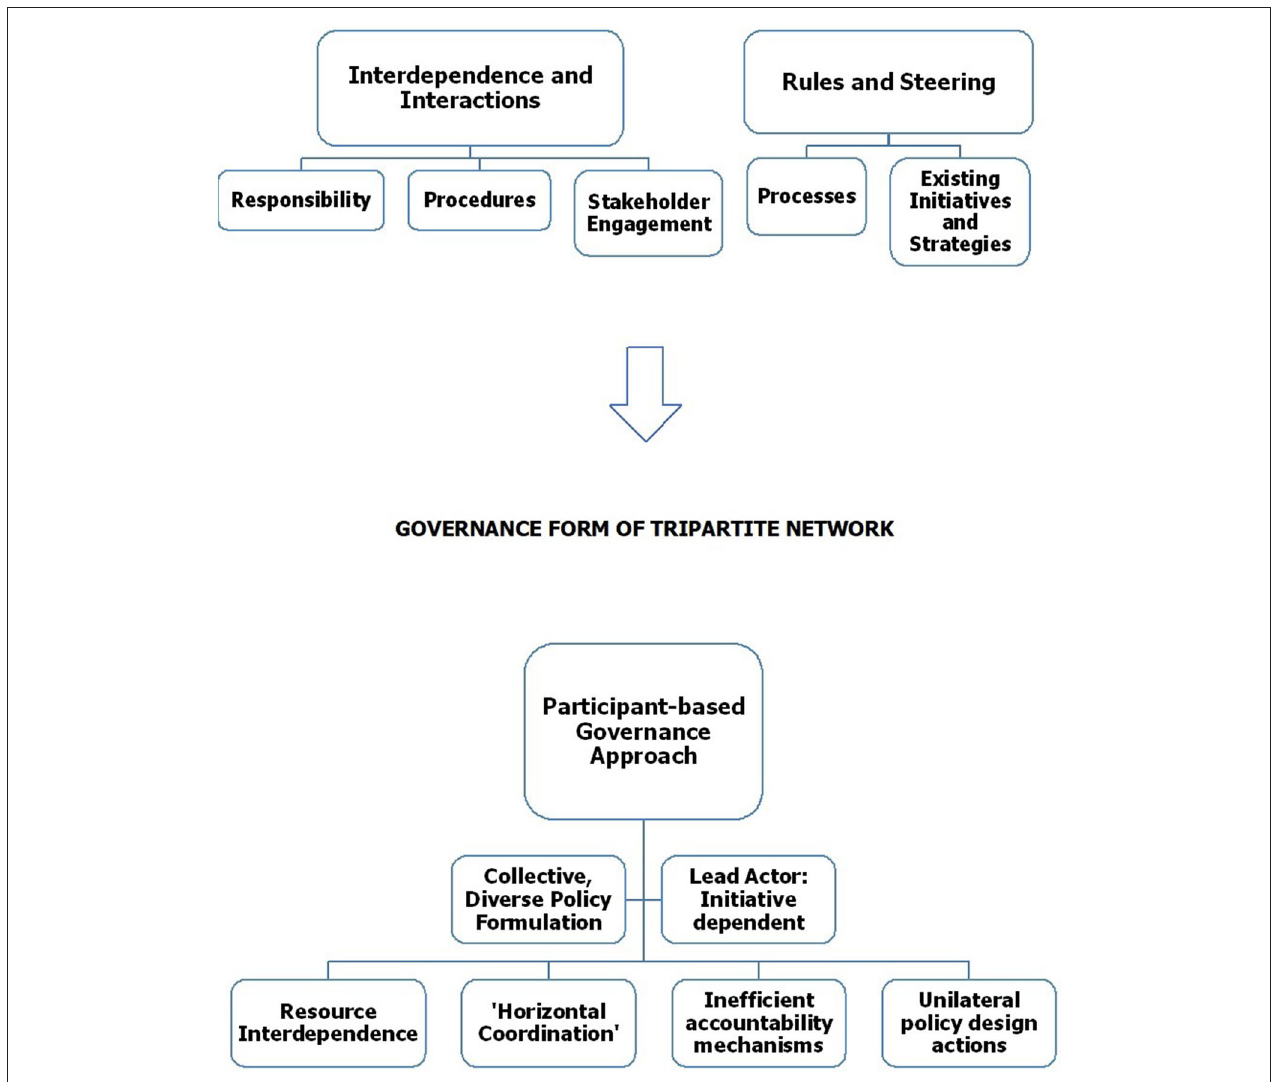
FIGURE 3 | Governance form of tripartite